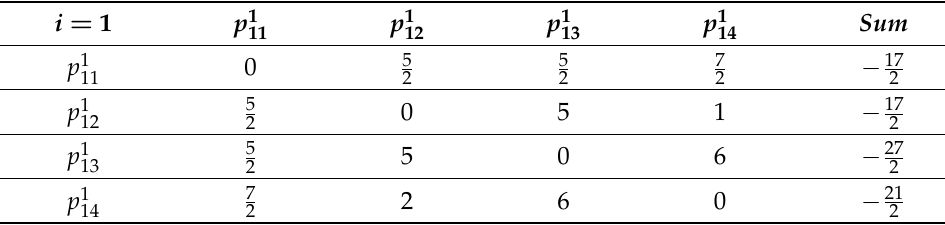
Table 2. The overall distance measure for the 1 st row of the matrix P 1 .